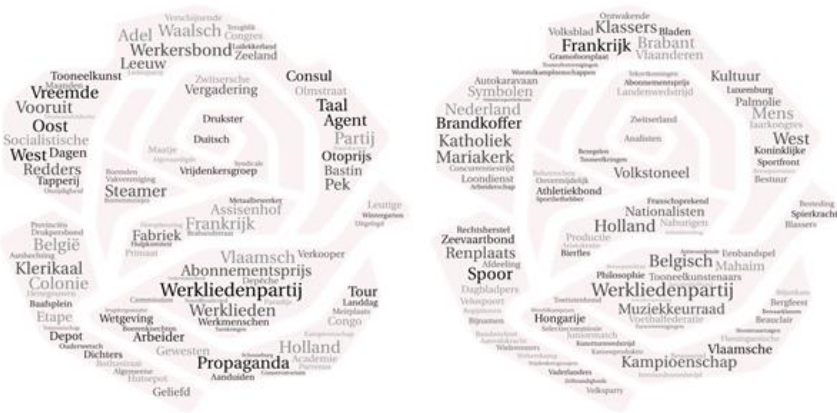
Fig. 6 Key associations with topic internationalism in Vooruit (1886-1938). Left: before the First World War. Right: 1918–38.